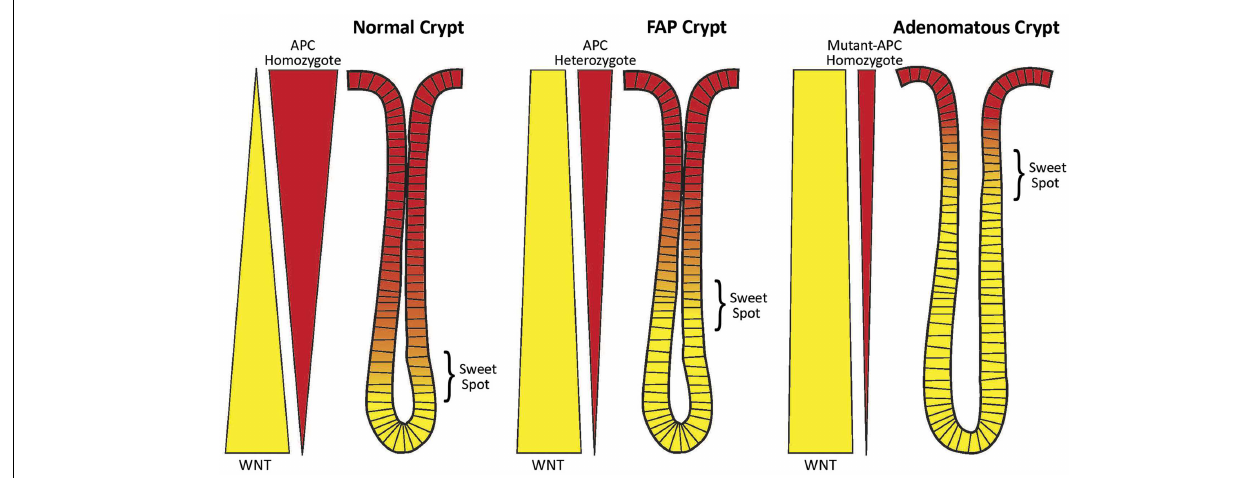
suppression ofWNT expression andWNT signaling (as indicated by the wider yellow wedge).The balance point, that is the “sweet spot,” has been shifted to a higher crypt level. Right Panel: In adenomatous crypts (mutant-APC homozygote), the changes inWNT expression (still wider yellow wedge) and APC expression (still narrower red wedge) are exacerbated due to a sporadic APC mutation in the second APC allele (the second hit). In mutant-APC homozygote cases truncated APC protein can retain some residual function. Here the “sweet spot” is shifted even further up the crypt. A consequence of these changes is an increase in the number of immature cells (including SCs) in the crypt.The SC overpopulation is thought to drive colon